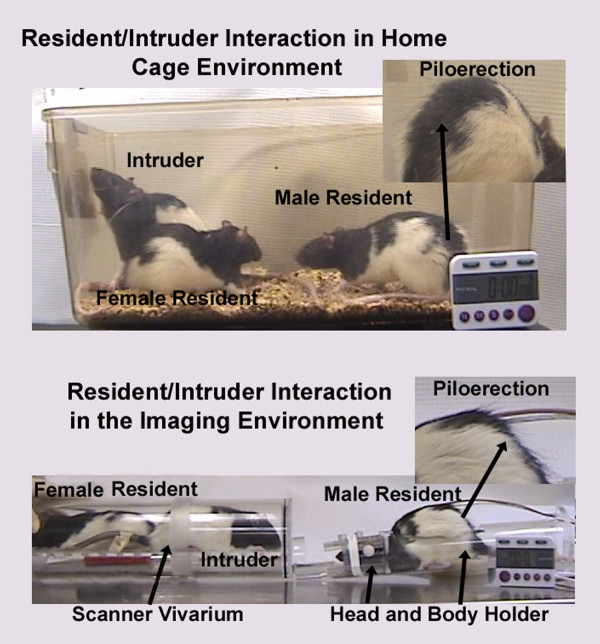
Piloerection in the homecage and imaging environment. The top photograph shows a male and female resident in their homecage moments after the introduction of a novel adult male intruder. The insert shows a photograph of piloerection along the midline back of the male resident. The bottom photograph shows a male resident with his head secured in the animal restrainer used for imaging. The animal's body is unrestrained and the body holder is open at the top to allow visualization of the animal's back. A vivarium designed to fit into the bore of the scanner immediately in front of the male resident is shown housing the resident's female partner and a novel adult male intruder. This presentation of stimulus animals in the vivarium elicits piloerection in the restrained male resident, an autonomic response that can be observed in the bore of the scanner during data acquisition.